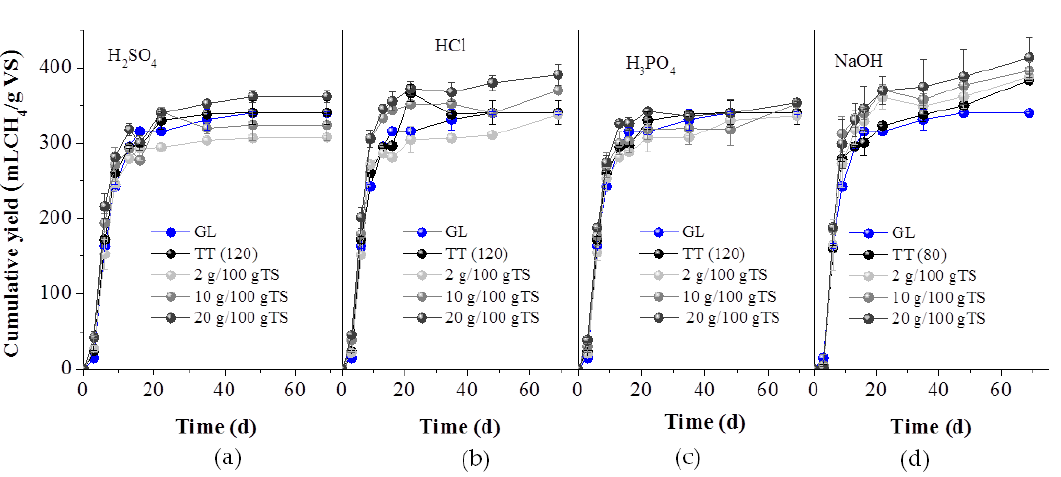
Figure 4. Cumulative methane yield of untreated (GL), thermally treated at 120 °C for 1h (TT (120)) or 80 °C for 24 h (TT (80)) and acid, with H 2 SO 4 ( a ), HCl ( b ), H 3 PO 4 ( c ) and alkali with NaOH ( d ), at the concentrations of 2, 10 and 20 g/100 gTS, respectively.